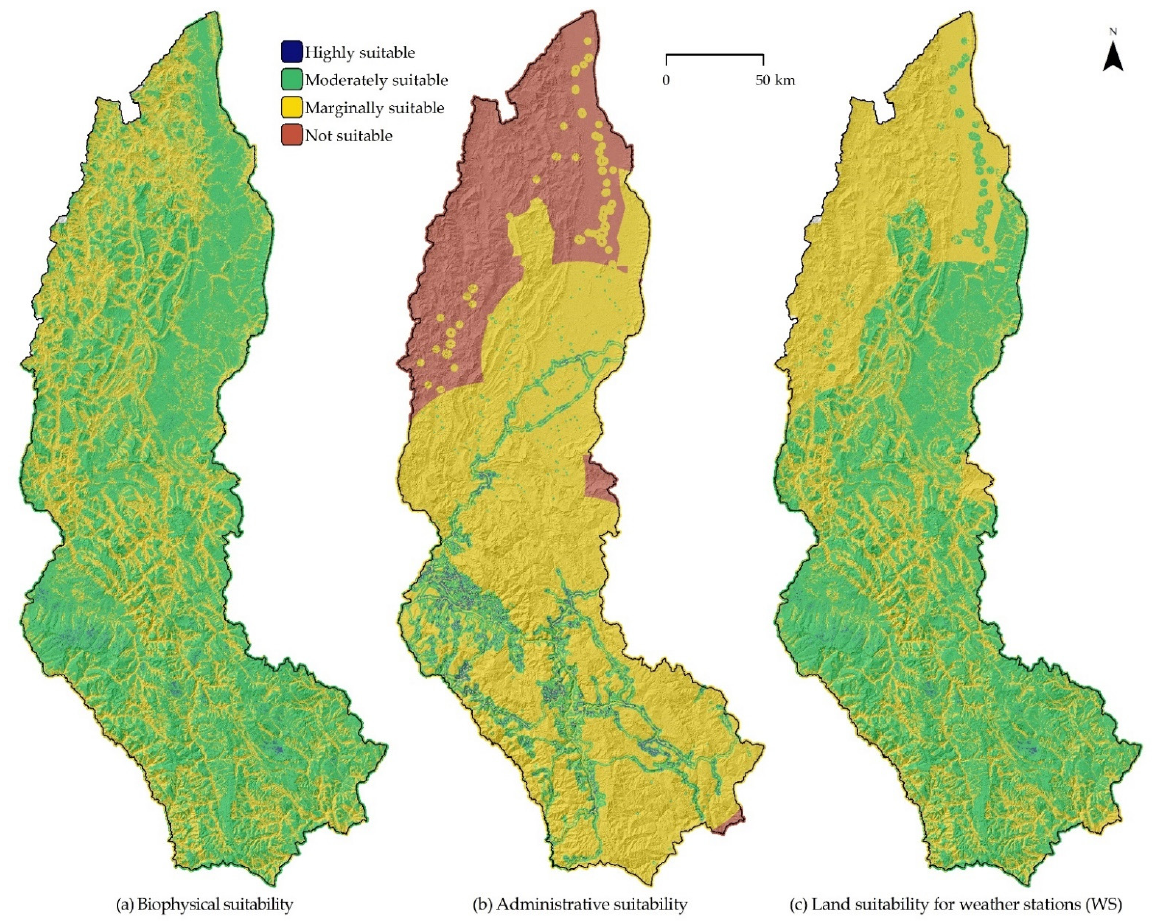
Figure 5. Suitability maps for selecting locations for weather stations in Amazonas, NW Peru. Table 6. Areas of suitability of sub-models for selecting sites for weather stations in Amazonas, NW